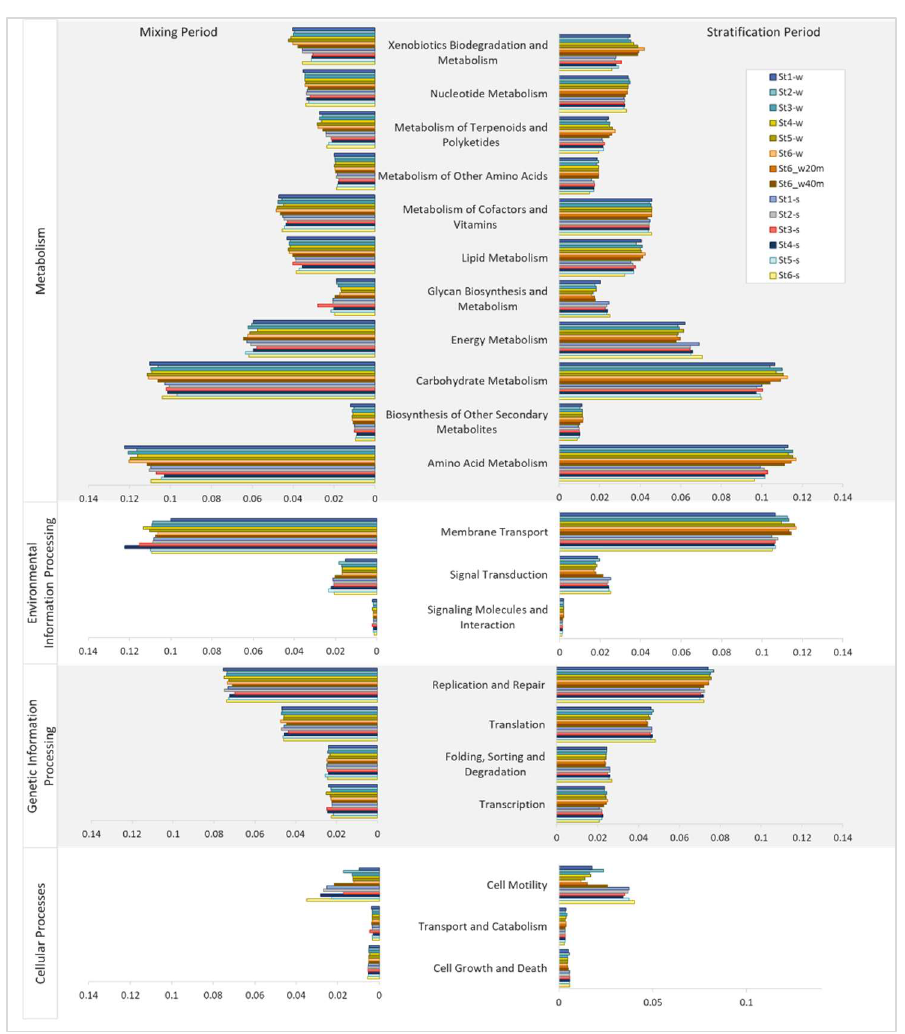
Figure 6. The predicted functional structure of the bacterial communities in the stratified